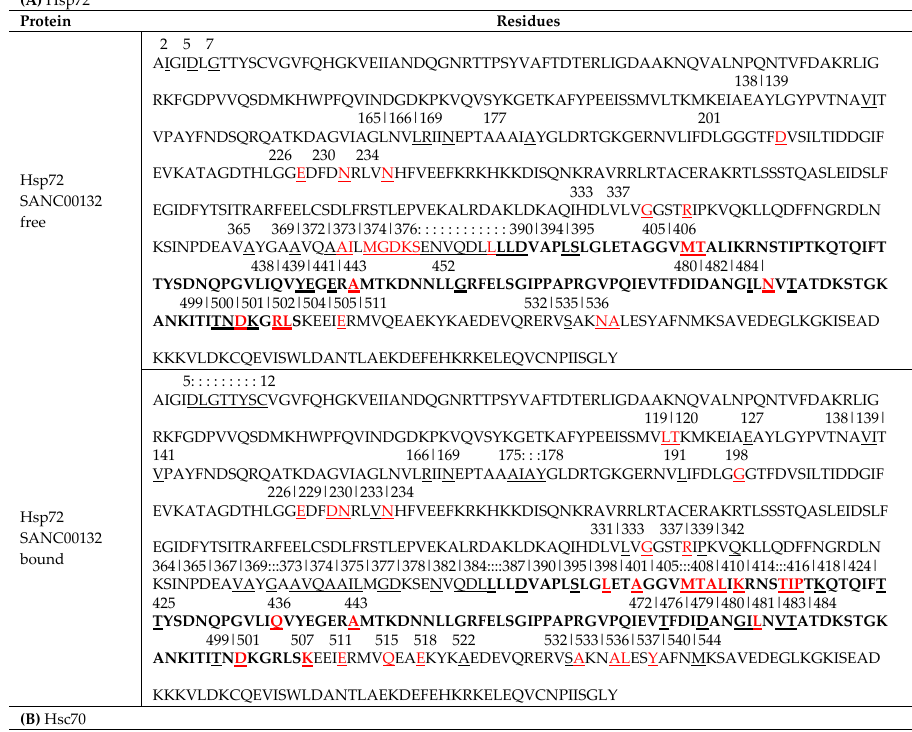
Table 3. ( A and B ) Tabulated summary of residues possessing high average BC indices across all ligand-free and ligand-bound trajectories of each protein. Identified residues and respective positions were mapped within the primary sequence. Residues are underlined while positions and numberings are indicated above the residues. Numbering is based on E. coli DnaK template sequence (UniProtKB ID: P0A6Y8). Continuous stretches of residue positions are indicated by colon punctuations. Residues highlighted in red represent residues agreeing with PRS results on E. coli DnaK [18]. Residues existing within the ligand binding site are shown in bold. Corresponding residue numbering from complete sequences of respective proteins are shown in Table S9A,B. Molecules 2018 , 23 , x FOR PEER